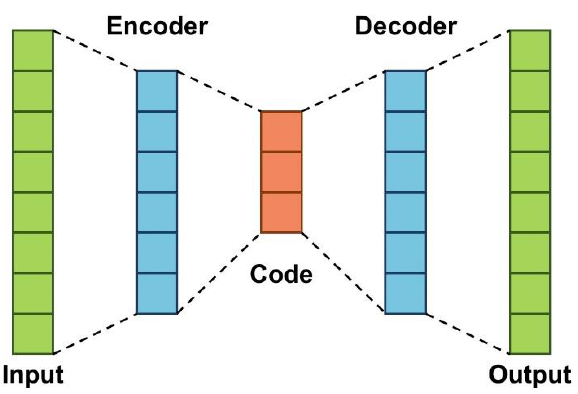
Figure 5. Schematic of an autoencoder. Source: Sezer et al. [14].